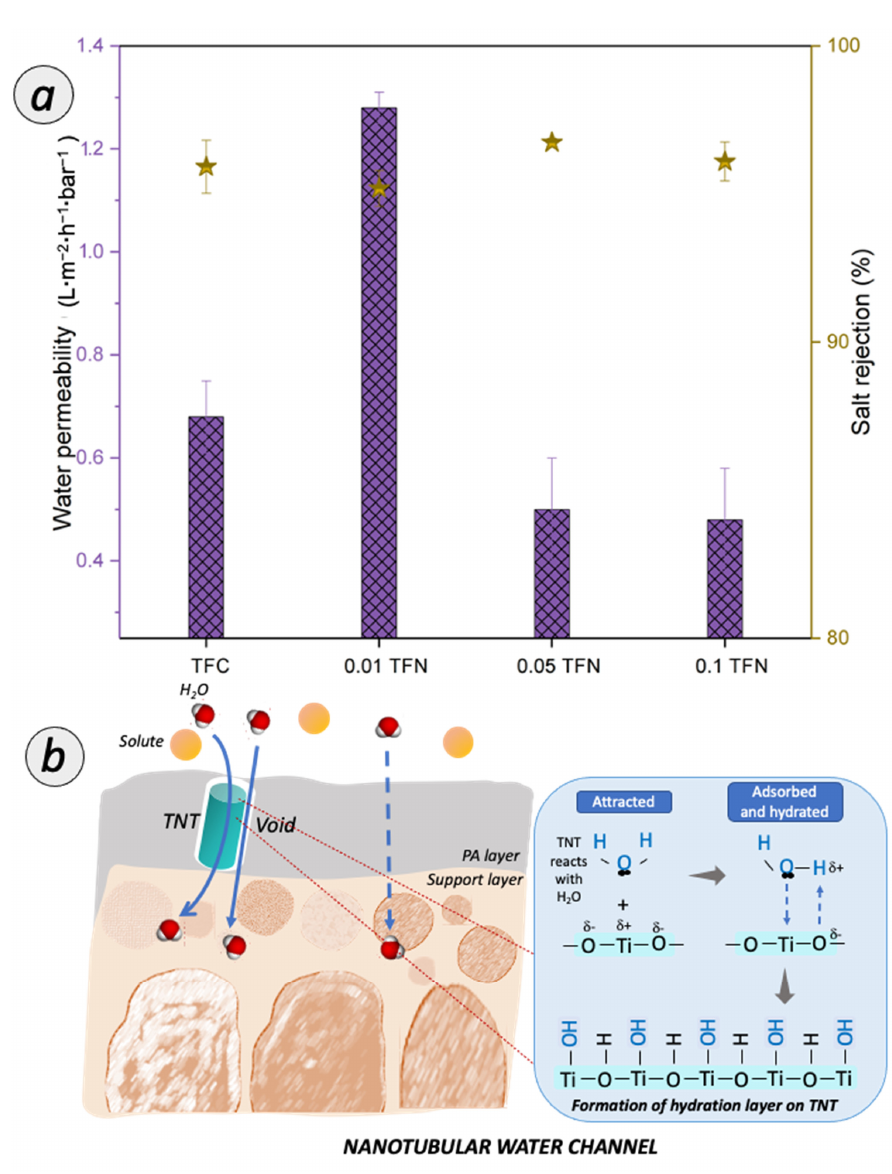
Figure 9. ( a ) Permeability and rejection of TFC and TFN membranes for desalination; ( b ) Possible pathway of water transport for TFN